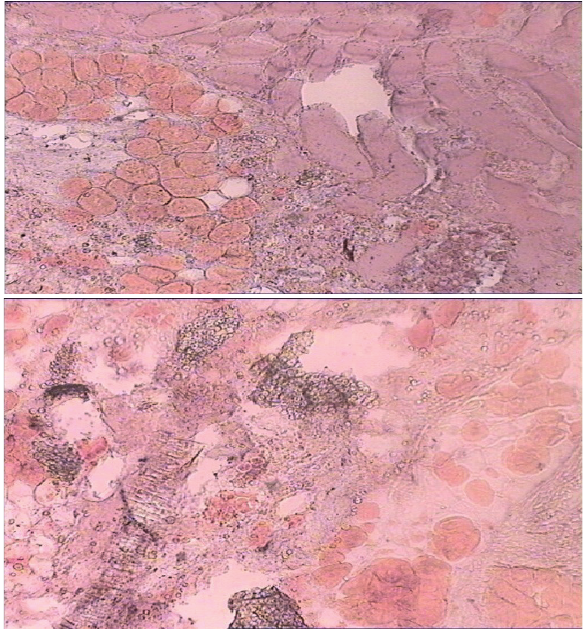
Figure 2 Microstructure of the national cooked and smoked meat product “Kanagat”